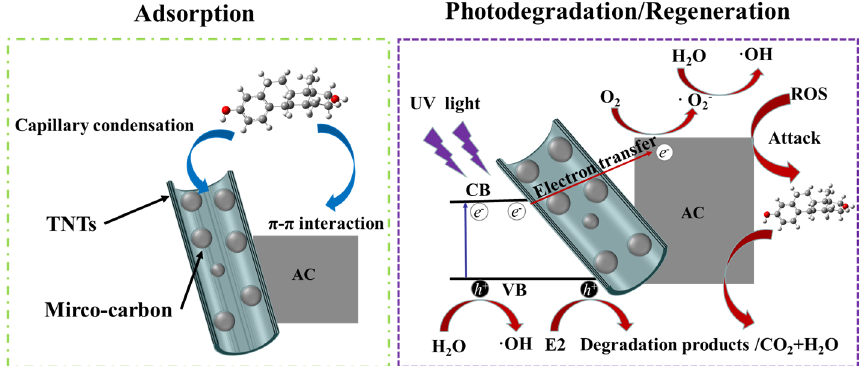
Figure 5. Schematic of the removal mechanism of E2 by TNTs@AC.